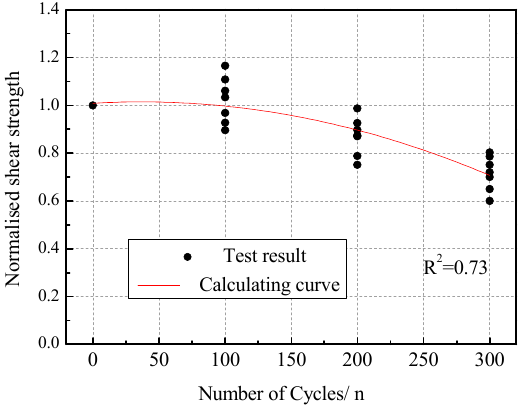
Figure 17. Shear strength attenuation model.